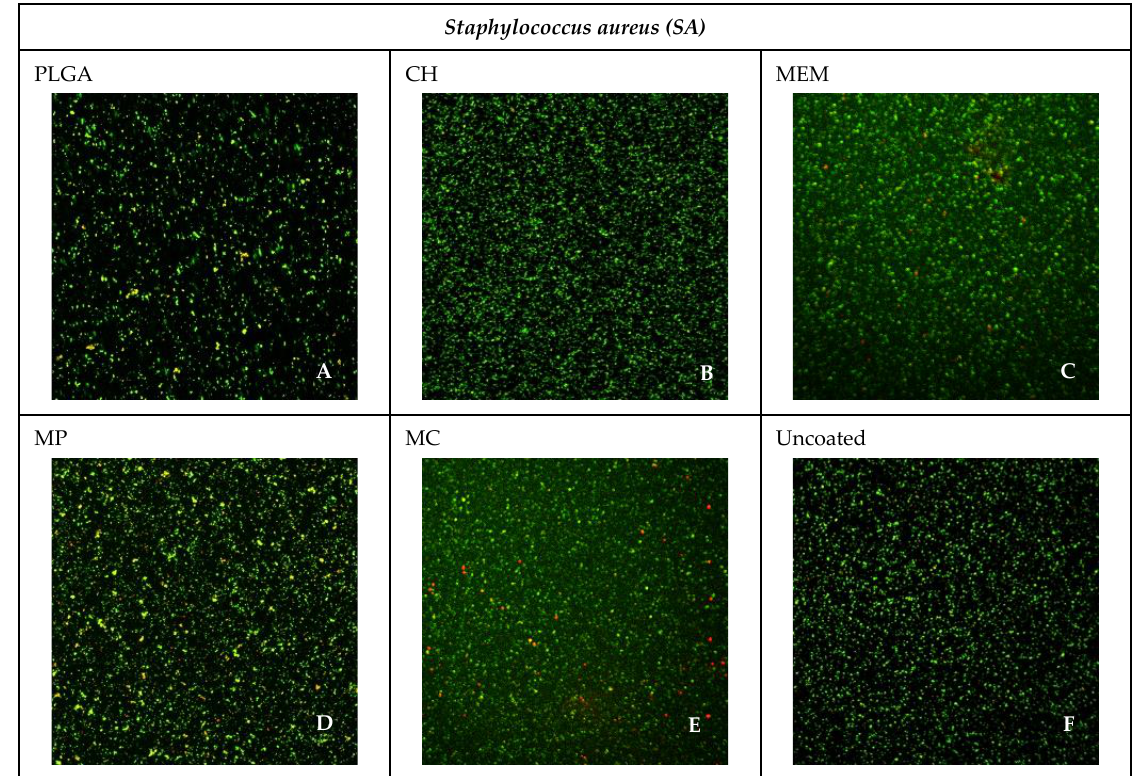
Antibiotics 2022 , 11 , 1565 10 of 15 Figure 5. Confocal microscope images of the different materials for SA. Figure 5. Confocal microscope images of the different materials for SA .